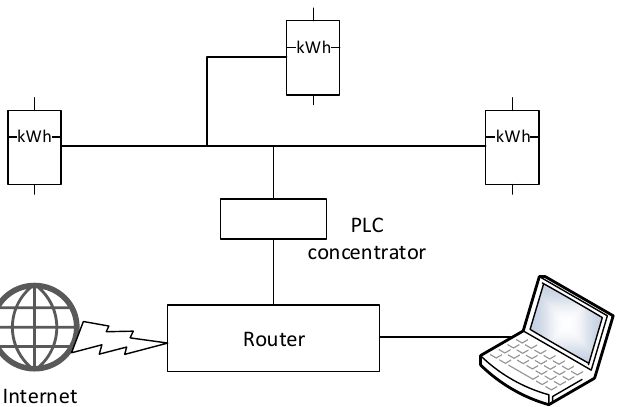
Figure 4. The laboratory setup: ( a ) electrical diagram of the test stand, ( b ) view of the power supply system in the form of programmable AC power supplies and model with power line communication (PLC) meters.